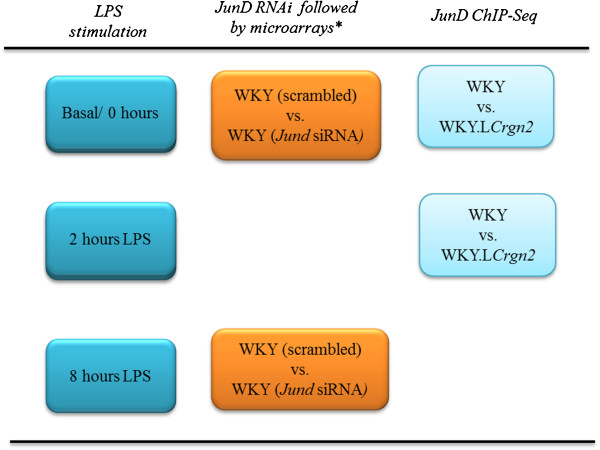
Strategy employed to identify primary JunD targets in bone marrow derived macrophages. We performed Jund RNAi and compared whole genome expression profiling in macrophages (basal and stimulated with LPS, 100ng/ml, 8h) transfected with scrambled siRNA to those transfected with Jund siRNA. ChIP-Seq analysis was performed in WKY and WKY.LCrgn2 BMDMs (basal and stimulated with LPS, 100ng/ml, 2h). Transcripts showing a fold change > 3 in the RNAi dataset were examined for JunD/AP1 peaks.